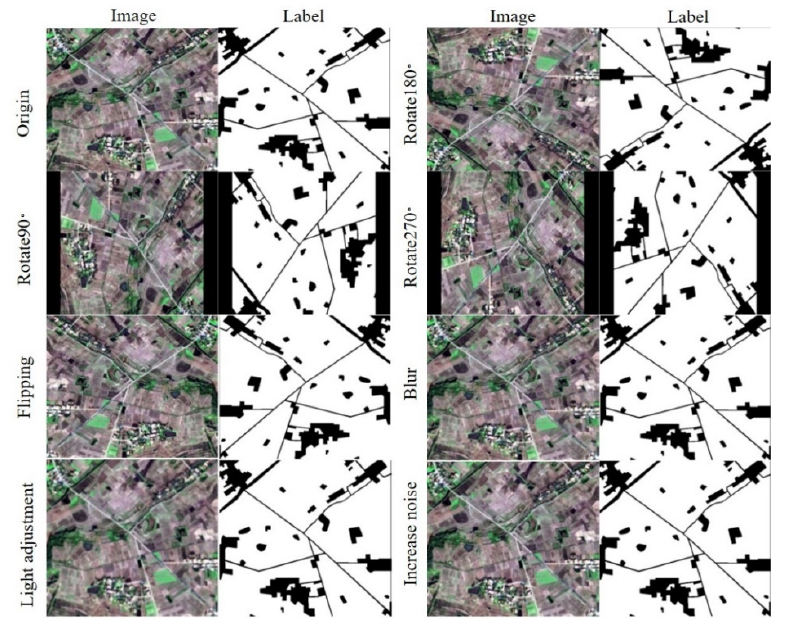
Figure 8. Data augmentation